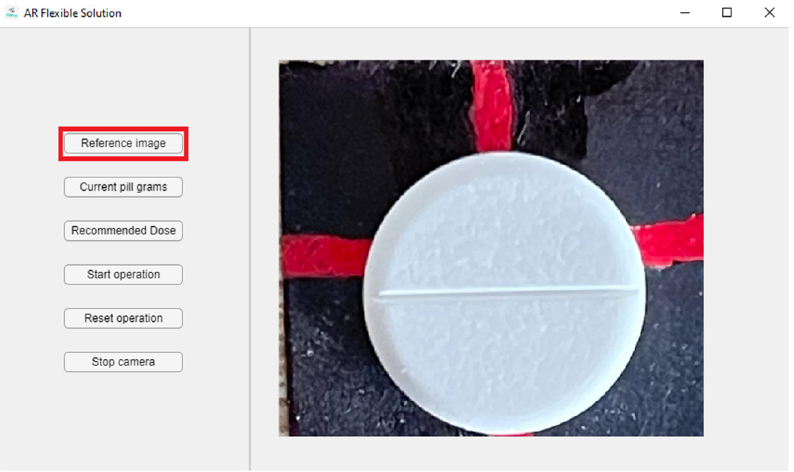
Figure 9. Capture of a reference image that may be divided.